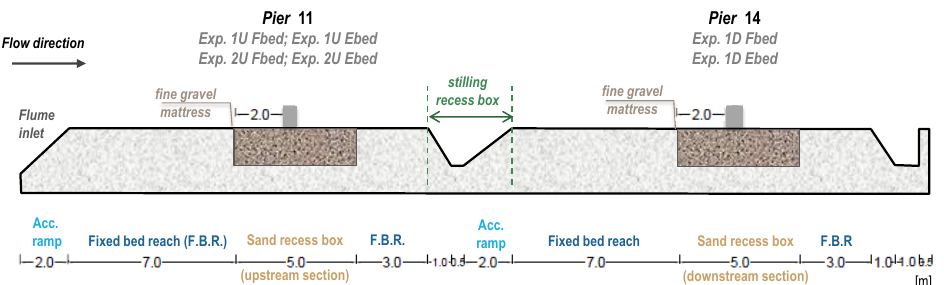
Figure 2. Schematic layout of the experimental setup (enlarged vertical scale).